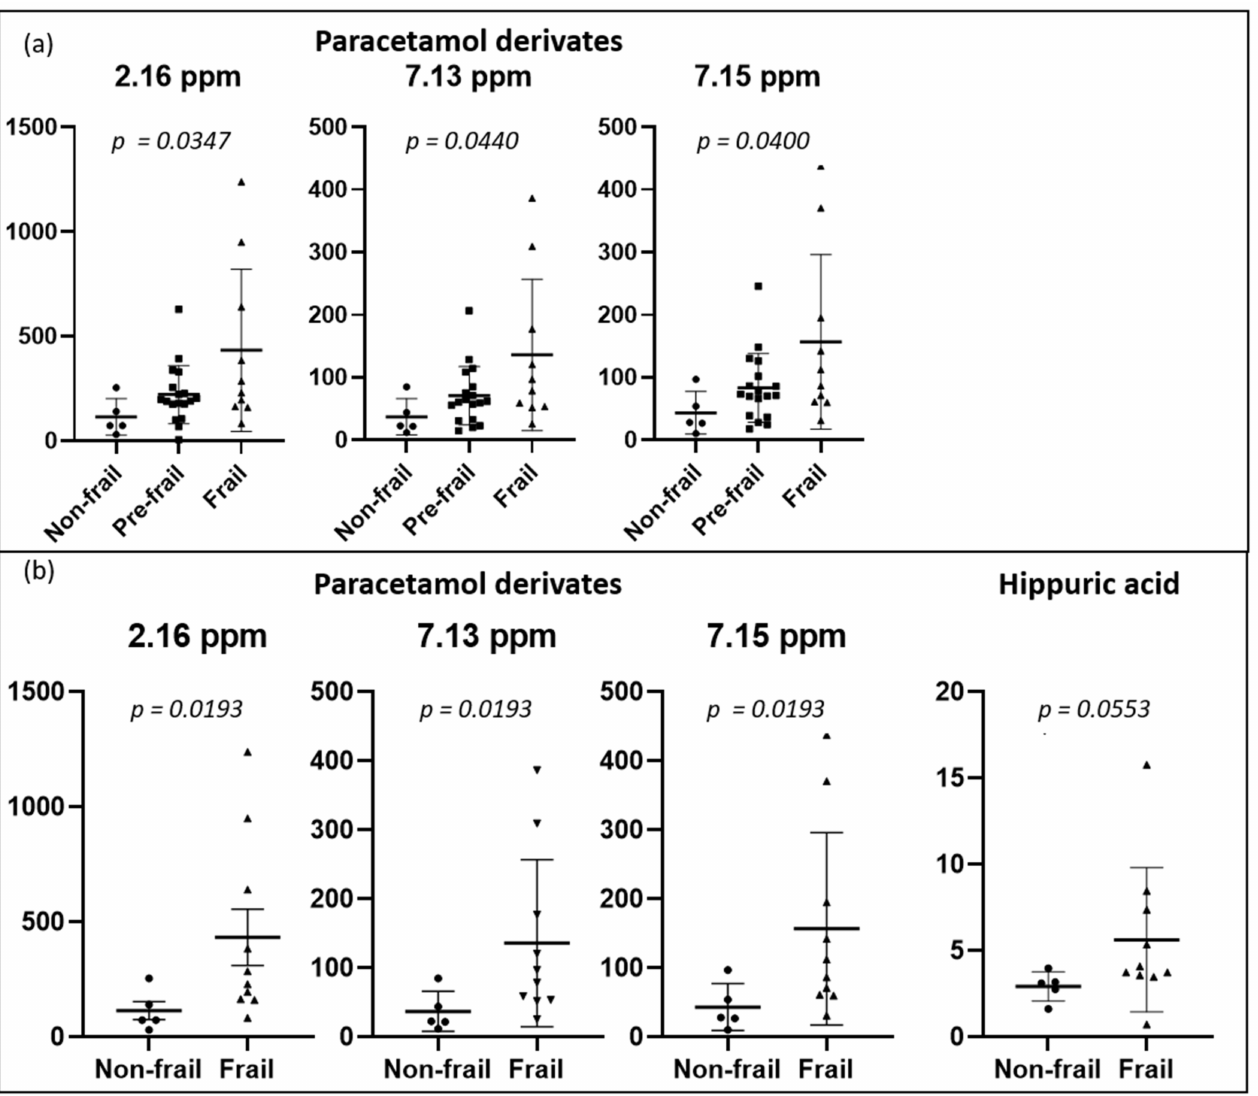
Figure 3. Dot plots of targeted metabolites showing significant differences between groups, ( a ) non- frail (n = 5) vs. pre-frail (n = 18) vs. frail (n = 10) participants, and ( b ) non-frail vs. frail participants. Plots represent mean ± standard